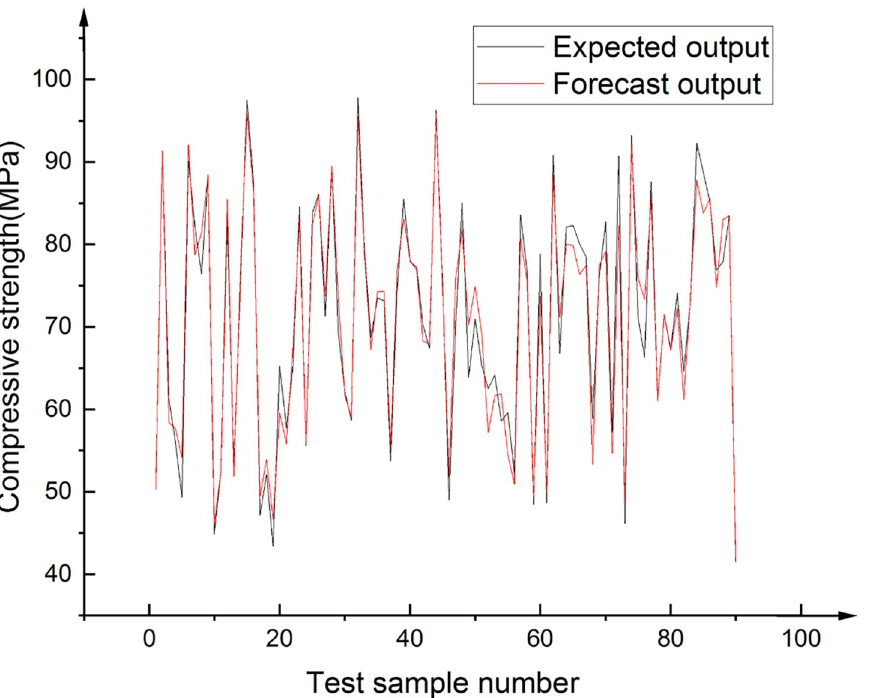
Fig 24. Comparison of test data and predictions by the best model.